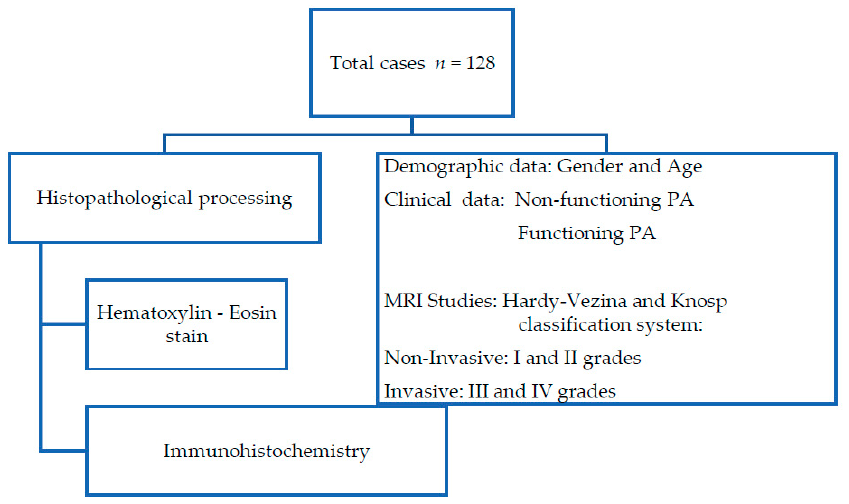
Figure 1. Flowchart of histopathological procedure and clinical data obtained from medical records.